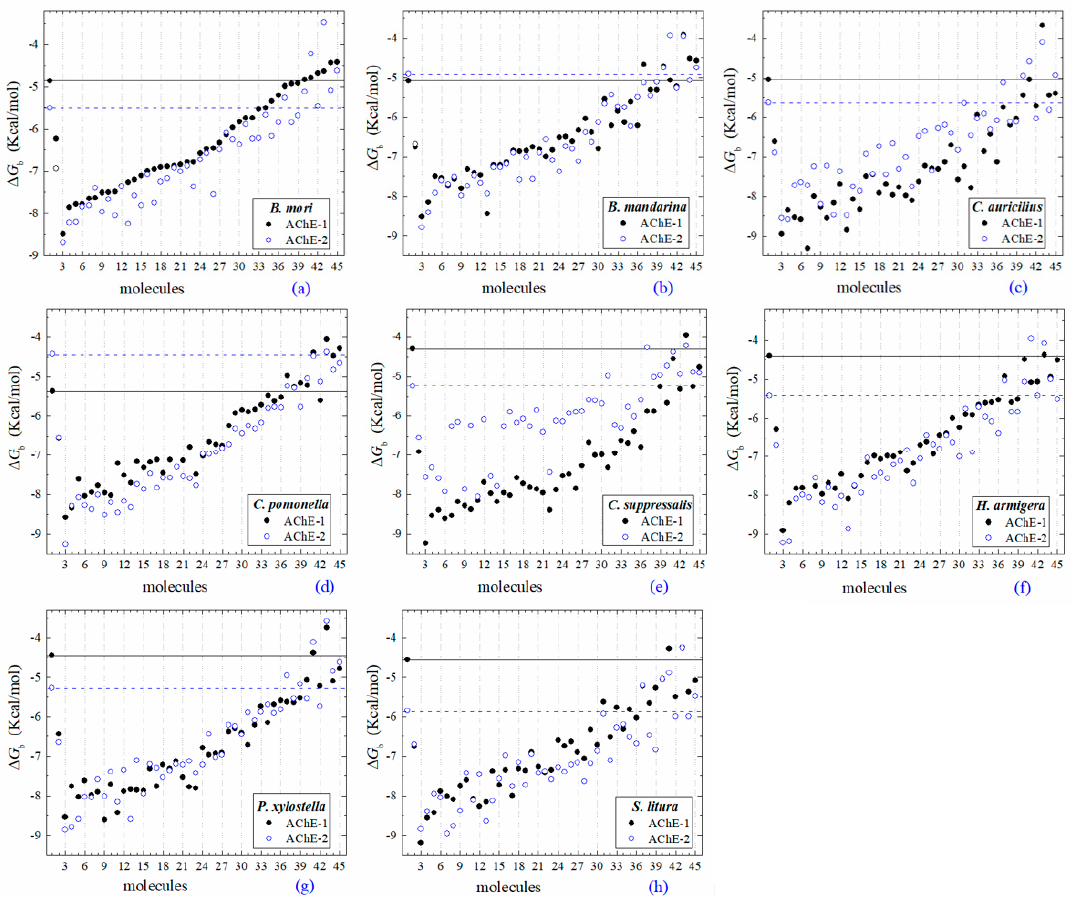
Figure 2. Molecular docking results of AChEs (AChE-1 and AChE-2, both wild type) in complex with molecules. AChE of the following organisms: B. mori ( a ), B. mandarina ( b ), C. auricilius ( c ), C. pomonella ( d ), C. suppressalis ( e ), H. armígera ( f ), P. xylostella ( g ), and S. litura ( h ). The molecules evaluated are the